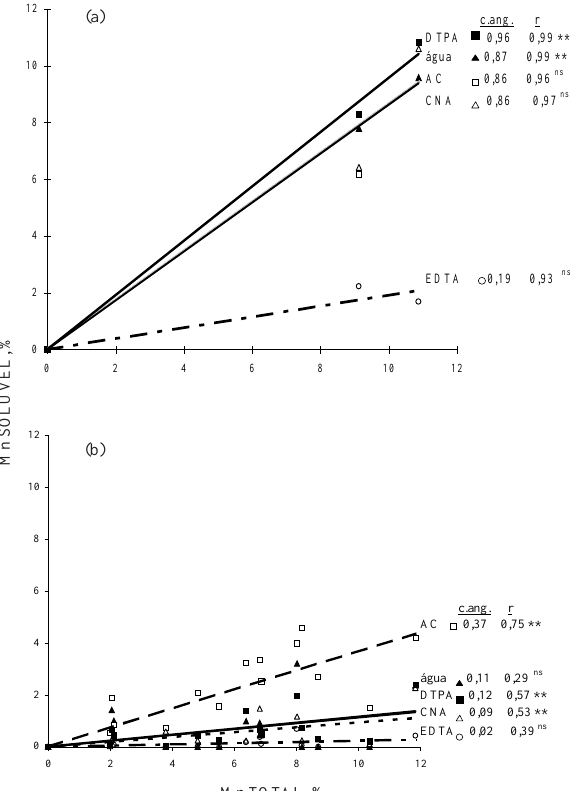
Figura 3. Solubilidade do manganês presente em fertilizantes comerciais solúveis (a) e insolúveis em água (b), nos diversos extratores utilizados, e respectivos coeficientes angulares das retas (c.ang.) e coeficientes de correlação (r). ** e ns significativos a 5% e não-significativo,